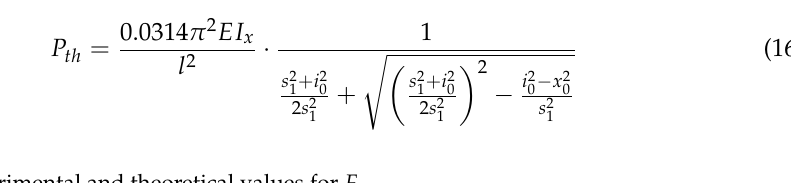
Table 2. The experimental and theoretical values for F max .